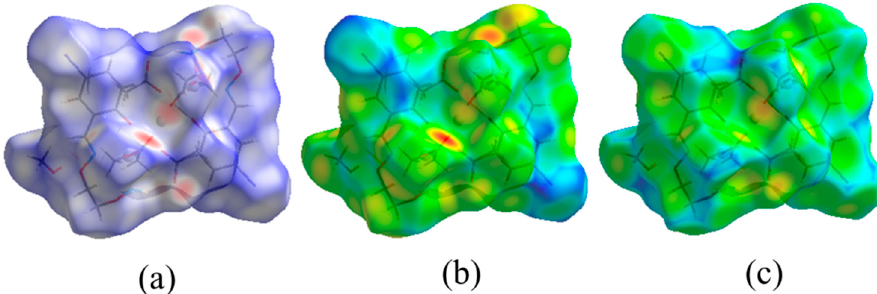
Figure 5. Hirshfeld surface analysis of the Ni(II) complex by d norm , d i , and d e mapping.